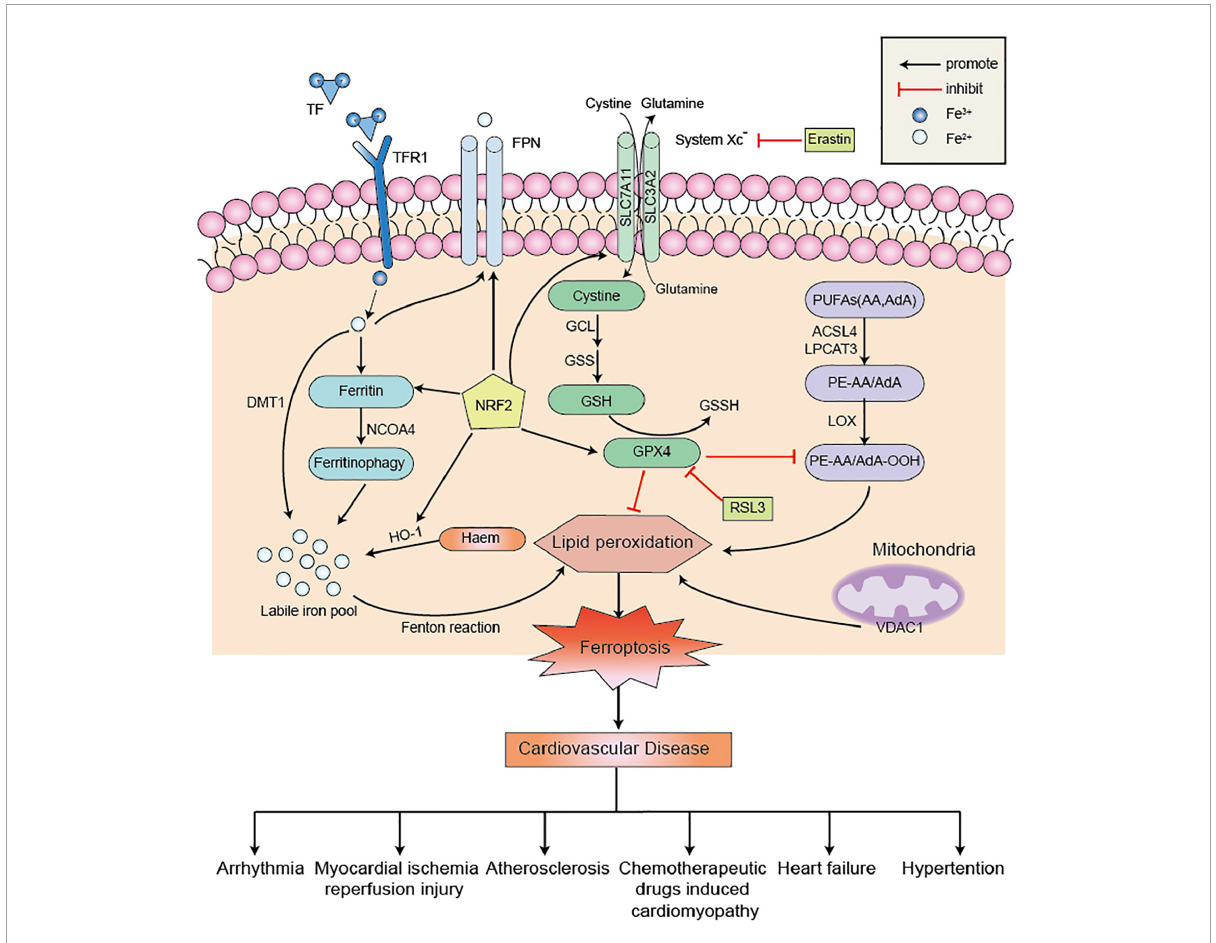
FIGURE1 The regulatory metabolic pathways in ferroptosis. Ferroptosis is a form of cell death characterized by iron overload and lipid peroxidation. Excessive iron uptake or decreased iron excretion leads to intracellular iron overload, which promotes Fenton reaction. GPX4 is an essential regulator factor in the System Xc − -GSH-GPX4 axis system to blocking ferroptosis. Besides, PUFAs can be catalyzed by ACSL4 and LPCAT3 to form PE-AA and PE-AdA, which is further oxidized by LOX to promote the occurrence of lipid peroxidation. These three metabolic pathways promote ferroptosis and further aggravate cardiovascular disease. NRF2 also acts as an antioxidant factor to inhibit ferroptosis by operating its downstream factors. Erastin and RSL3 are common ferroptosis inducers to promote ferroptosis. PUFAs, polyunsaturated fatty acids; AA, arachidonic acid; AdA, adrenic acid; ACSL4, acyl-coa synthetase long chain 4; LPCAT3, lysophosphatidyl acyltransferase 3; LOX, lipoxygenase; System Xc − , cystine/glutamate antiporter; GSSH, glutathione disulfide; GSH, glutathione; TF, transferrin; TFR1, transferrin receptor 1; DMT1, divalent metal transporter 1; FPN, ferroportin; HO-1, heme oxygenase-1; NCOA4, nuclear receptor coactivator 4; NRF2, nuclear factor erythroid-2 related factor 2; RSL3, Ras-selective lethal small molecule 3; VDAC1, voltage-dependent anion channel 1; GPX4, glutathione peroxidase 4; PE,